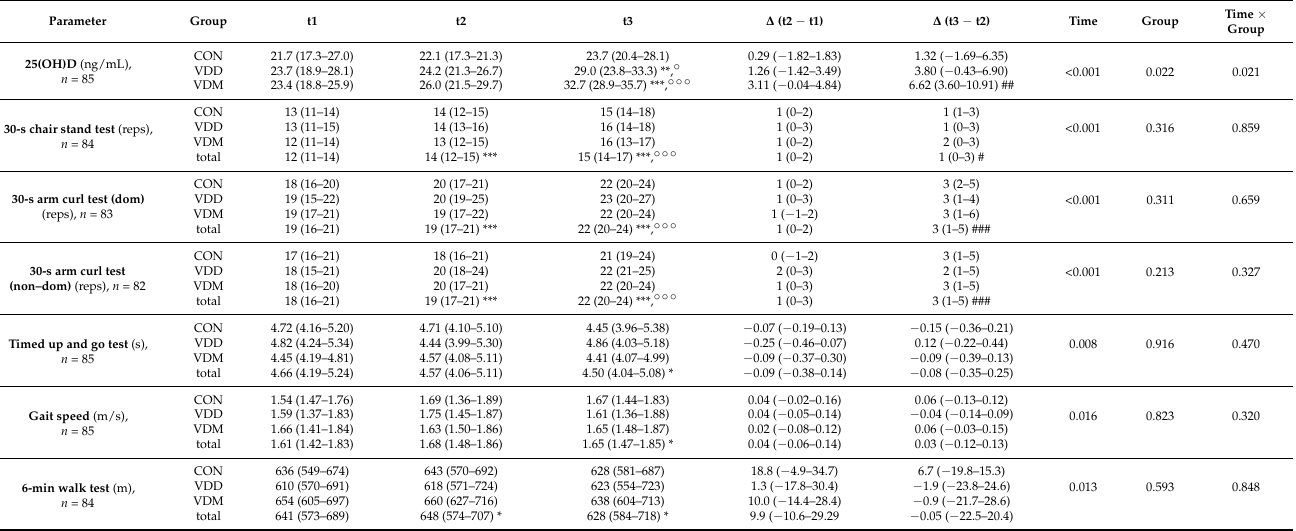
Table 2. Effects of vitamin D3 supplementation and RT on functional